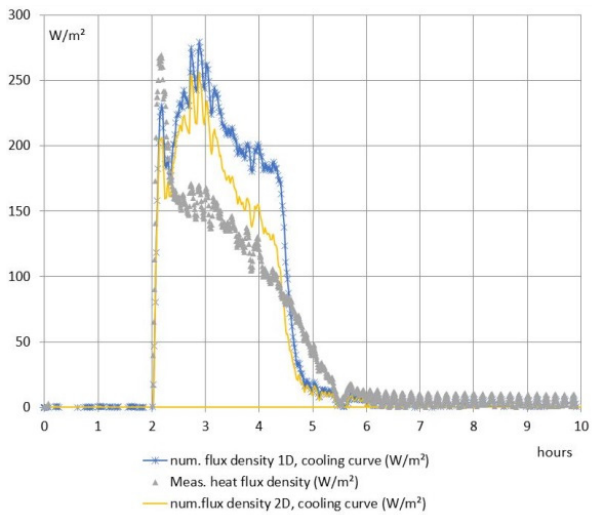
Figure 11. Comparison between 1D and 2D results for heat flux density to container surface. Cooling case—cooling heat capacity curve.